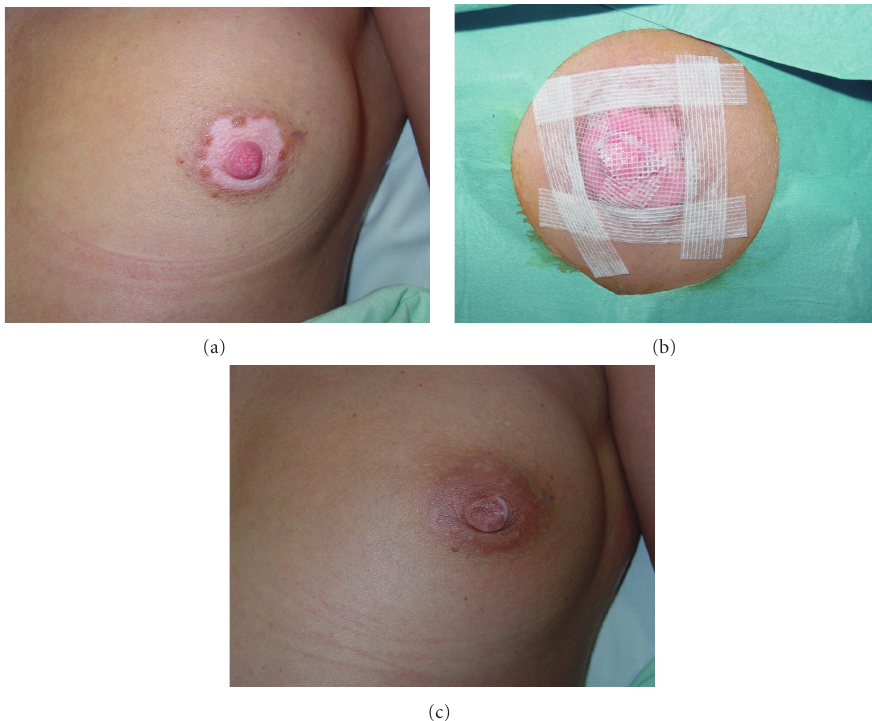
Figure 2: Patient 1. Preoperatively (a); the achromic epidermis was removed using CO 2 laser, and AM carrying cultured melanocytes on the basement membrane surface was applied on the denuded area with one layer of Vaseline gauze. The amniotic membranes were fixed with steri-strips and covered with dry gauze and adhesive tape (b); postoperative photography ( > 90% repigmentation at 16 weeks)